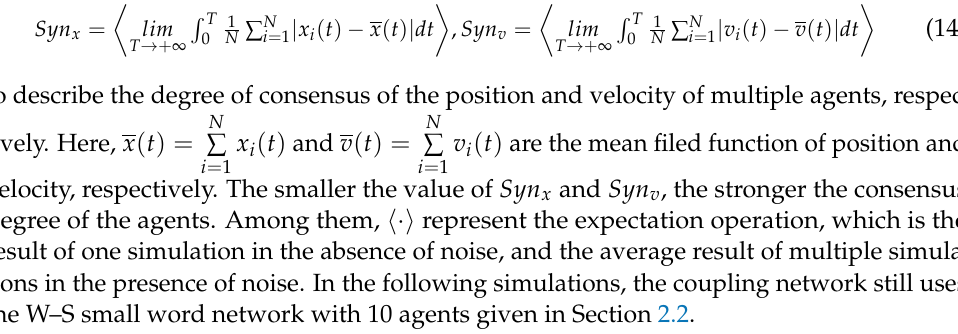
Figure 6. The curves of the position/velocity of each agent as a function of time of FOMAS (3) with orders 𝑝 = 0.8 ( a , b ) and 𝑝 = 0.3 ( c , d )(the case 𝑑 < 0 ).